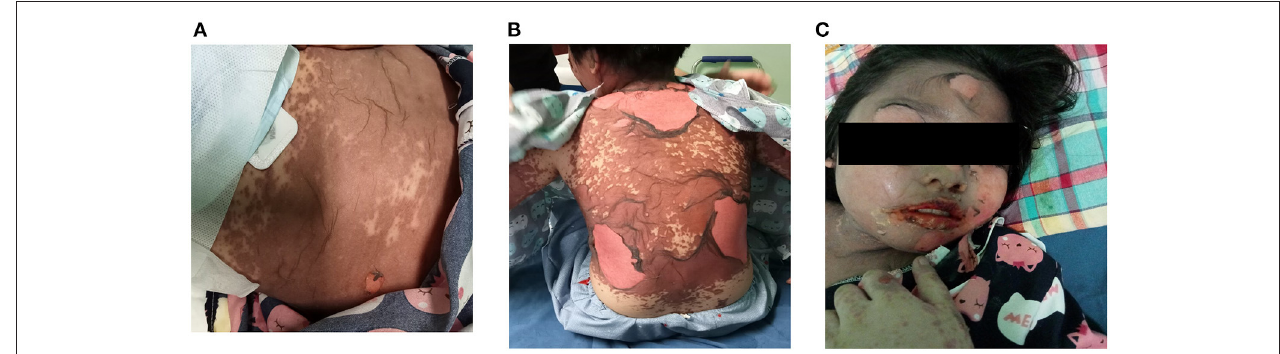
FIGURE 1 | (A,B) A widespread epidermal detachment on the abdomen and back on hospital admission (day 4 of the illness). (C) Hemorrhagic crusting of the lips and skin